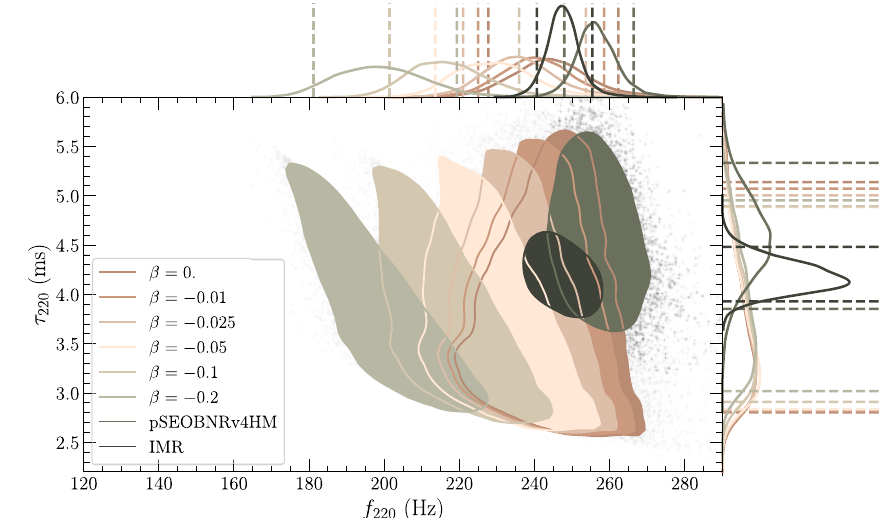
Fig. 2 90% credible levels of the 2D posterior probability distributions, and the marginalised 1D posterior probability distributions (with the 90% credible intervals) of the frequency f n (cid:3) m and damping time τ n (cid:3) m of the (cid:3) = 2 = m mode. The pSEOBNRv4HM posterior probability distribution is from [100] while the IMR posterior is from [10]. From the above posteriors, values of β (cid:2) − 0 . 05 seem to be inconsistent with the pSEOBNRv4HM and IMR